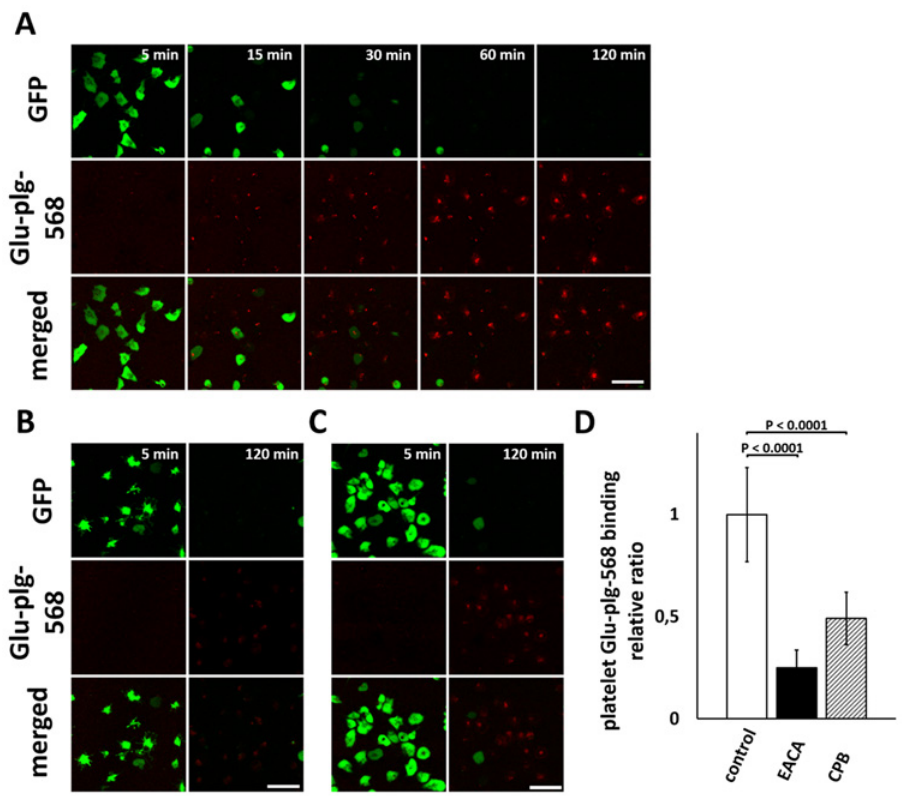
568, and accumulation of Glu-plg-568 on the surface of platelets was monitored over time by CLSM either in the absence (A) or in the presence of 100 mM EACA (B) or 15 U/ml CPB (C). Representative CLSM images are shown at the indicated time points after addition of IMC. A decrease in GFP fluorescence intensity in individual platelets indicates the full activation of platelets with PS exposure on the surface, as a result of a sustained elevation of intracellular calcium ion concentration caused by IMC. The decrease in GFP fluorescence intensity was followed by gradual binding of Glu-plg-568 to the platelet surfaces, which was strongly limited by EACA and CPB. The scale bars represent 10 μ m. (D) The platelet Glu-plg-568 binding relative ratio was expressed as the integrated fluorescence intensity of Glu-plg-568 bound to the surface of activated platelet 120 minutes after IMC supplementation and divided by the area of the platelet (n = 30 activated platelets from three independent experiments in each column). This assay was analyzed with a t -test for independent samples. Results are normalized to the control sample mean value (mean ±